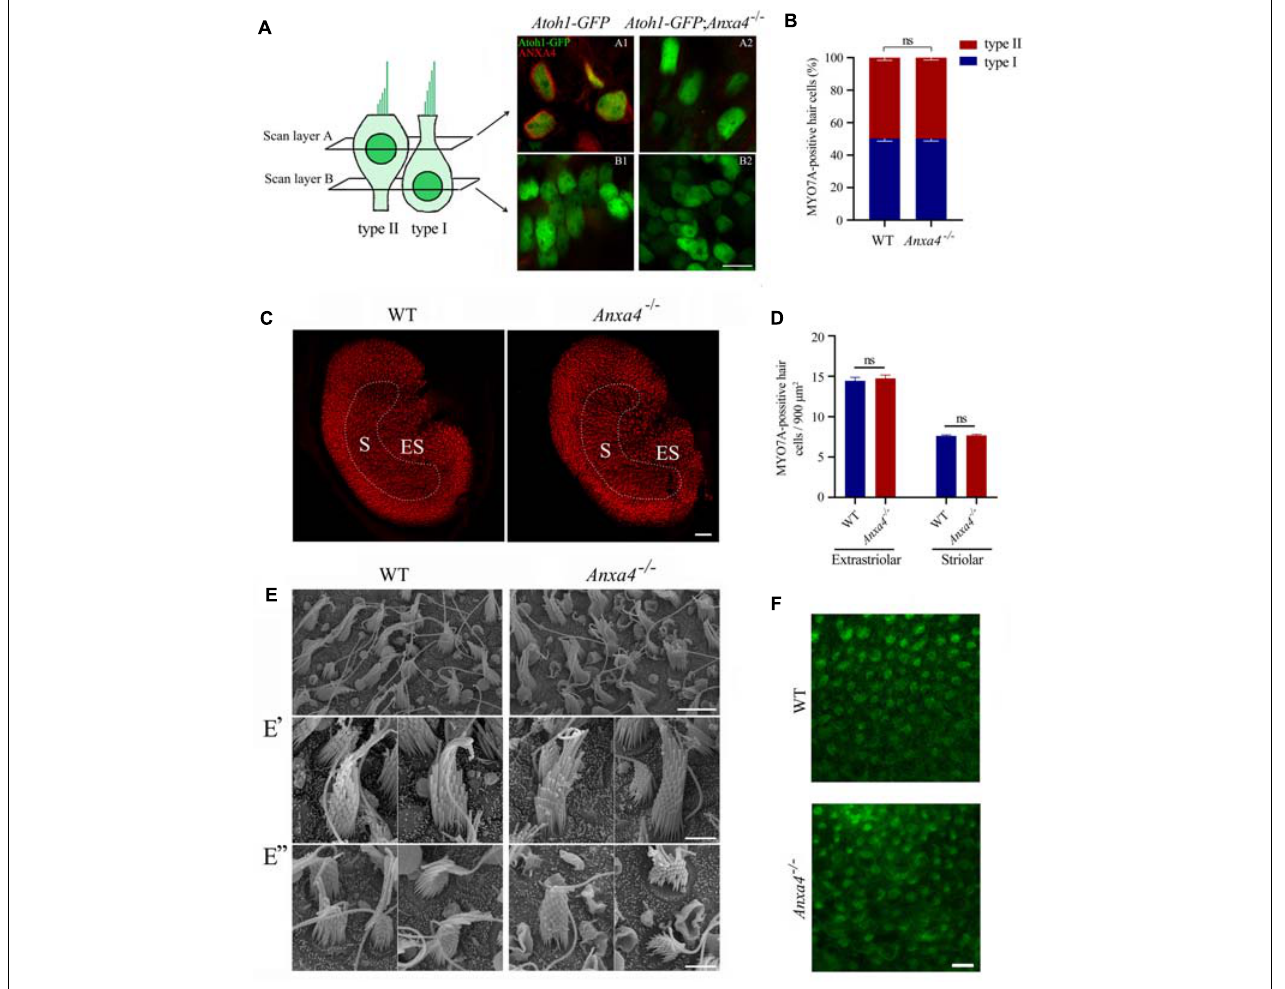
FIGURE 3 | VHCs are unaffected in Anxa4 − / − mice. (A) VHCs in the utricle of P60 Atoh1-GFP or Atoh1-GFP ; Anxa4 − / − mice were stained with anti-ANXA4 antibody (R&D Systems). Hair cells were labeled by nuclear GFP. Confocal microscopy images were taken at different levels as indicated. (B) VHCs in the utricle of P60 wild type or Anxa4 − / − mice were stained with anti-MYO7A antibody, and numbers of type I and type II MYO7A-positive VHCs were calculated. (C) VHCs in the utricle of P60 wild type or Anxa4 − / − mice were stained with TRITC-conjugated phalloidin and imaged with confocal microscope. (D) Numbers of striolar or extrastriolar phalloidin-positive VHCs were calculated according to the results from (C) . (E) Examination of utricle hair bundles of P60 wild type or Anxa4 − / − mice using SEM. (E’,E”) Higher resolution SEM images of type I and type II VHCs, respectively. (F) FM1-43FX uptake by VHCs of utricle in P7 wild type or Anxa4 − / − mice was examined using confocal microscope. The numbers of animals used in each groups in (B,D) are 3. Scale bars, 10 µ m in (A,F) , 5 µ m in (E) , 2 µ m in (E’,E”) , 50 µ m in (C) . ns, not significant.